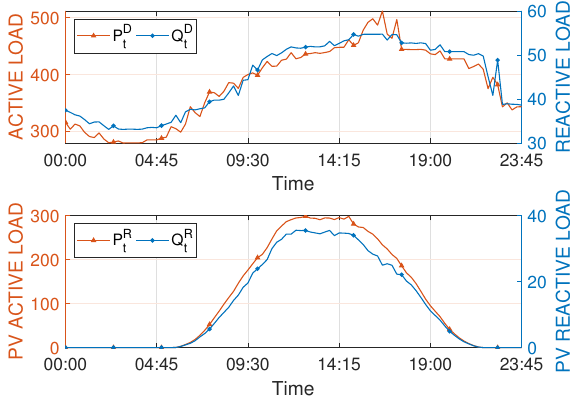
Figure 6. Active/reactive load and solar power output data during 24 h (sampling every 15